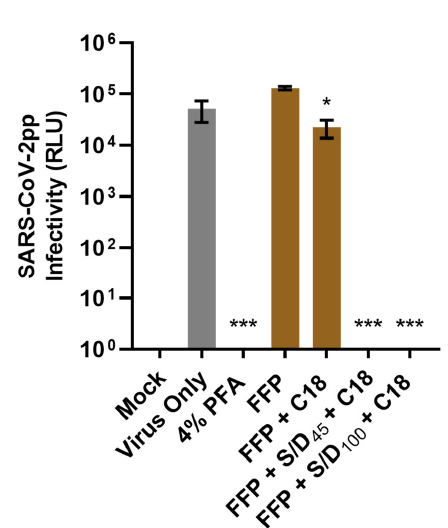
Figure 3. S/D treatments completely inactivate SARS-CoV-2pp from plasma. Huh-7 cells were infected with SARS-CoV-2pp-spiked freshly frozen plasma (FFP), SARS-CoV-2pp-spiked FFP treated with C18 cartridge filtration (FFP + C18), SARS-CoV-2pp-spiked FFP treated with 1% TnBP/1% Triton X-45 followed by C18 cartridge filtration (FFP + S/D 45 + C18), or SARS-CoV-2pp-spiked FFP treated with 1% TnBP/1% Triton X-100 followed by C18 cartridge filtration (FFP + S/D 100 + C18) for 1.5 h. Viral infectivity was measured by luciferase reporter activity (relative light units; RLU) after 72 h incubation. Data shown are collected in triplicate and expressed as mean ± standard deviation (SD). Statistical significance was analyzed by one-way ANOVA with Dunnett’s multiple comparisons test (* p ≤ 0.05 and *** p ≤ 0.001 compared to Virus Only). Viruses 2022 , 14 , 2419